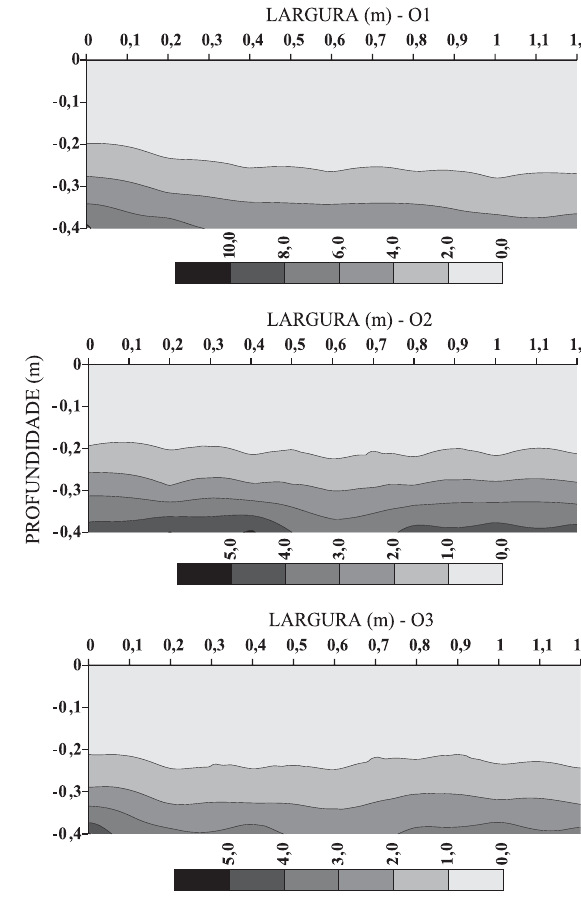
Figura 4. Mapa de isolinhas do atributo RP (MPa) no perfil do solo preparado com uma (O1), duas (O2) e três (O3) operações da grade leve off-set com discos de 0,56 m de